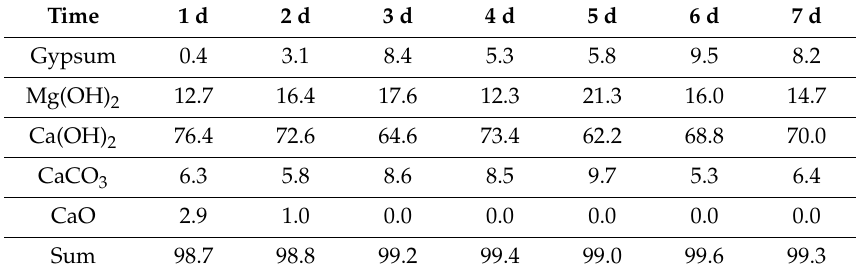
Table 8. Bulk composition (%) of solids from reaction of 1% fine CaO with sea water versus time at 5 °C for 1–7 days.